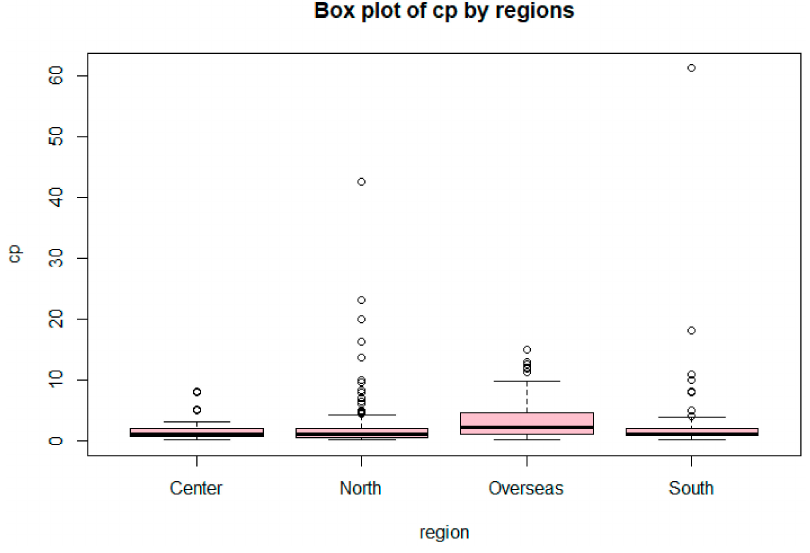
Figure 3. A box plot of “ cp ”—Relative productivity distribution by